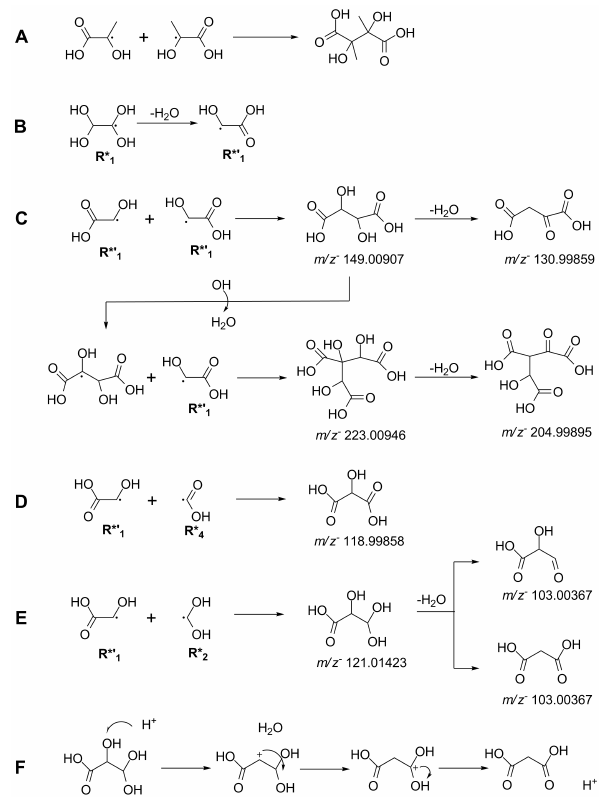
Fig. 3. (A) Formation of 2,3-dimethyltartaric acid via radical- radical reactions (Guzmann et al., 2006). (B) Dehydration of the glyoxal radical (Burchill and Perron, 1971). (C) Formation of tar- taric acid ( m/z − 149) via radical-radical reactions followed by de- hydration. (D) Formation of tartronic acid ( m/z − 119) vial radical- radical reactions. (E) Formation via radical-radical reactions fol- lowed by dehydration. (F) Proposed acid-catalyzed dehydration for the formation of malonic